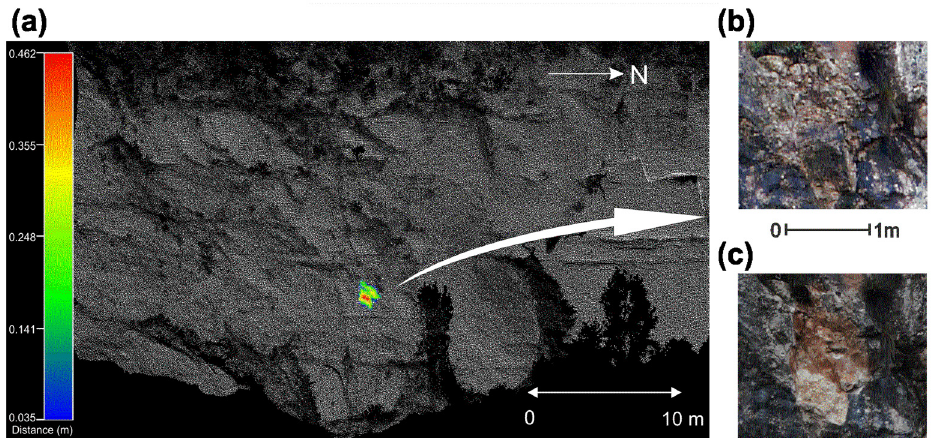
Figure 9. ( a ) Point cloud intensity in Degotalls E with the difference feature values of cluster #1326 (South section, period 2017–2019) shown in a multi-color scale. The dimensions in this example are 1.4 m (height) and 1 m (wide). ( b ) Cluster image before the rockfall. ( c ) Image post rockfall where the wedge and the surface of the fractures that control the detachment are visible (Fracture set A and the conjugate fracture set B with orientation NE-SW). This rockfall was classified as a large block. Table 11. Summary of features of the cluster shown in Figure 9. Cluster #1326 (Degotalls The total number of clusters labeled as “Candidate” and validated as rockfall events at E, south section, period 2017–2019). Degotalls E during the monitoring period was 65. At Degotalls N the number of